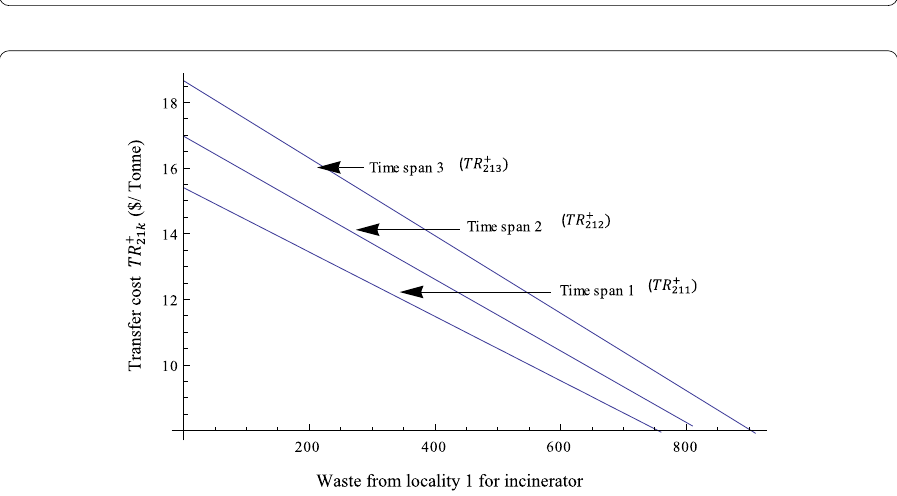
Figure 6 Upper bound of waste collection and transfer cost from locality 1 to incinerator